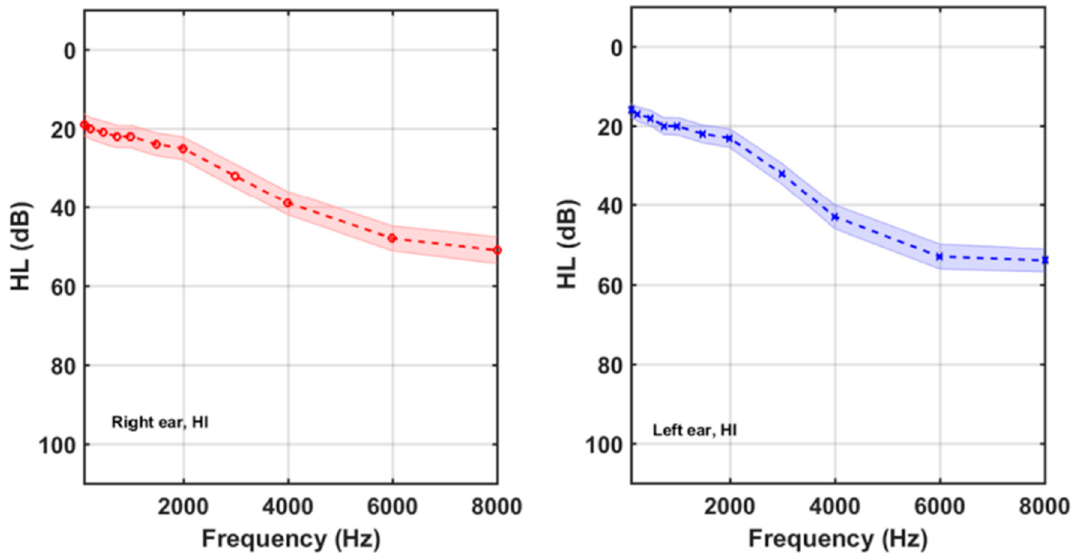
Figure 4. Right and left average audiograms of the 61 participants of the HI subgroup. Shaded areas around the mean curves display the 95% confidence intervals.